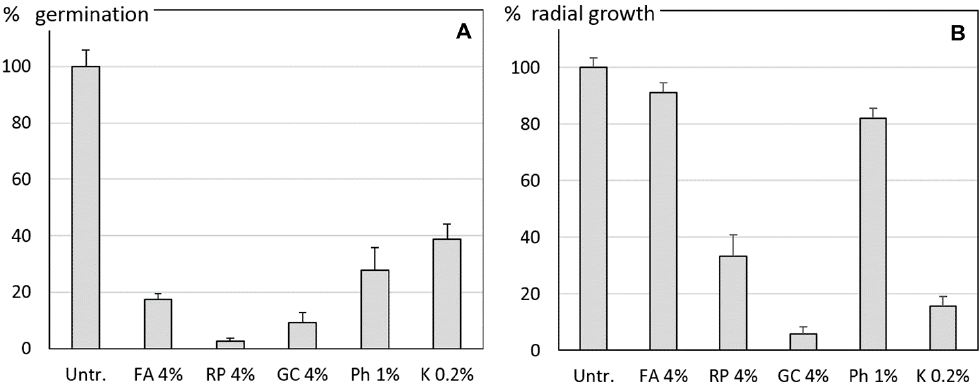
Figure 1. In vitro experiments on ( A ) the mean germination of Phytophthora infestans (Pi) sporangia and ( B ) the radial mycelium growth of Pi. Effect of 4% suspensions of the botanicals Frangula alnus (FA), Rheum palmatum (RP) and Galla chinensis (GC), of a 1% suspension of Phosfik ® (Ph) and of 0.2% Kocide DF (K). Untr. = Untreated control with water. Error bars indicate the standard errors of the means